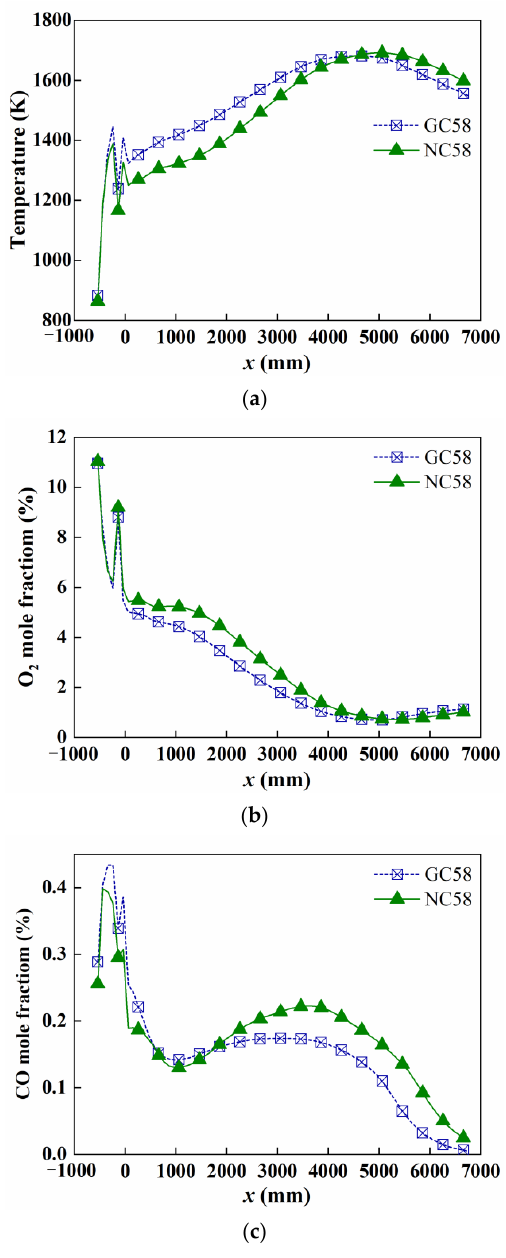
Figure 14. Distribution of the average temperature and species mole fraction along x -axis. ( a ) Tem- perature distribution. ( b ) O 2 mole fraction distribution. ( c ) CO mole fraction distribution.